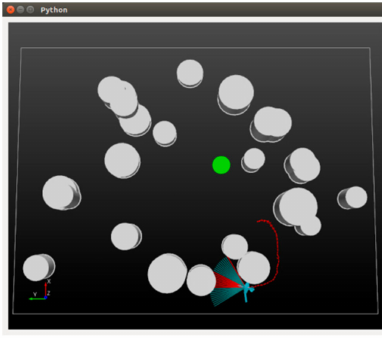
Figure 6. The experimental